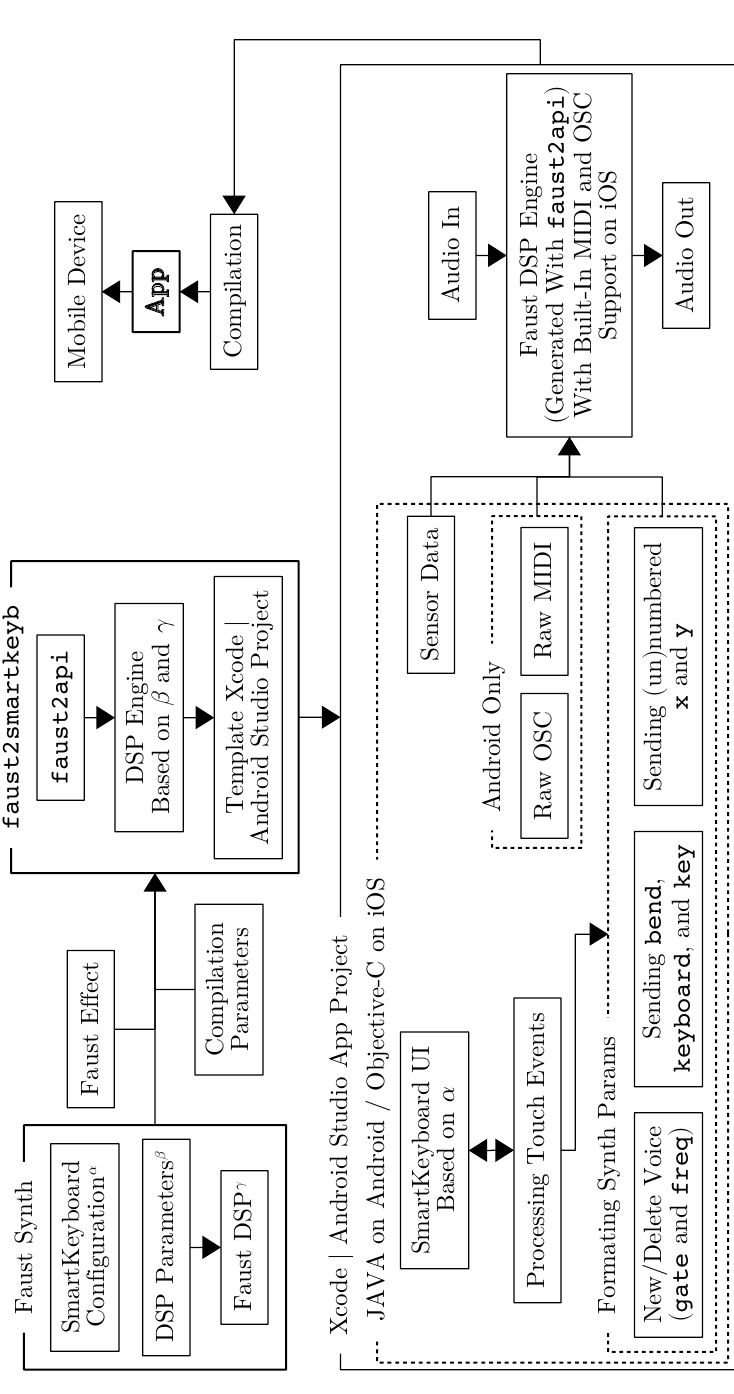
Figure 1. Overview of faust2smartkeyb